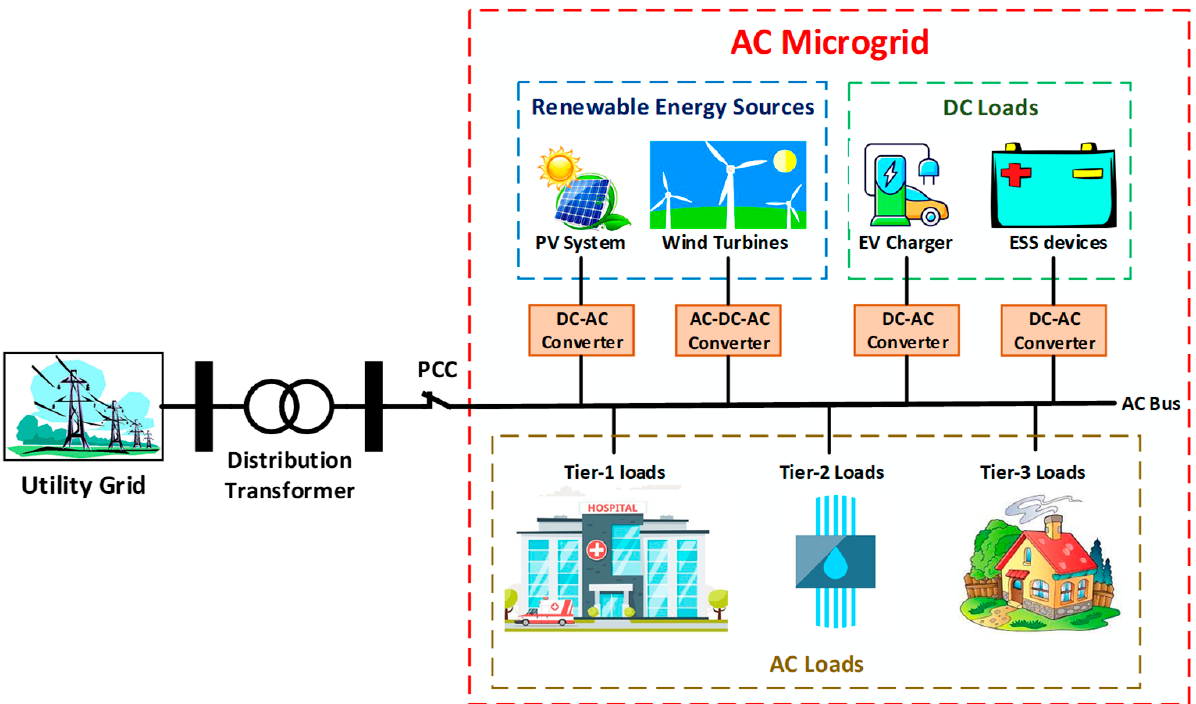
Figure 1. Simple diagram of a typical ACMG.